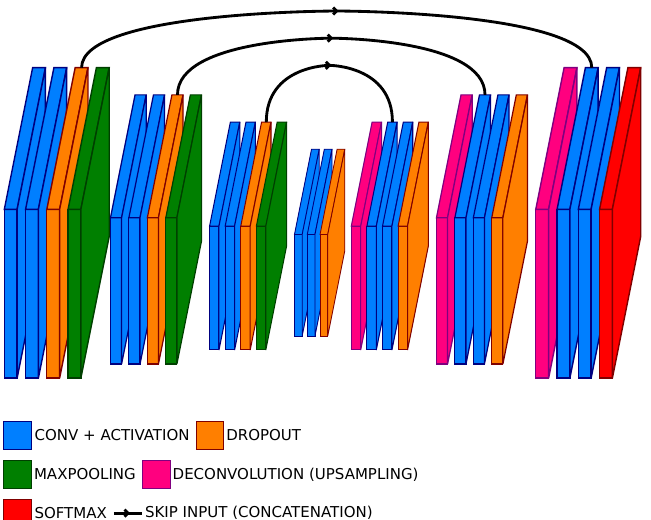
Figure 1. Architecture of our Bayesian U-Net (BU-Net) model with a block size of 2 and 3